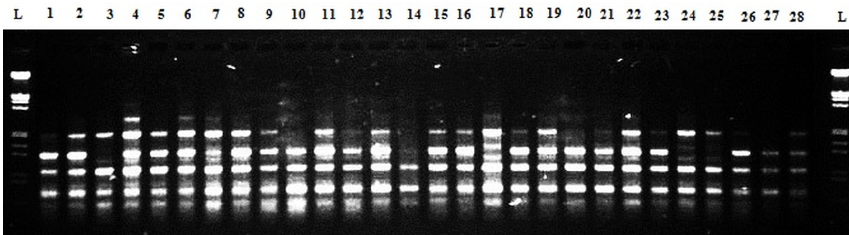
Fig. 3. Example of ISSR gel with ISSR-19 primer. The first twenty-eight cultivars represented in Tab. 1 are displayed from left to right. Ladders were run in the outside two